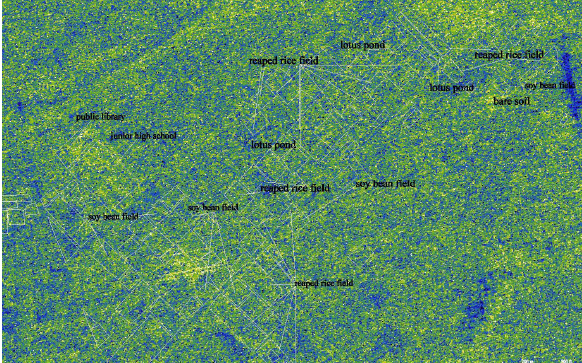
Figure 10. Zooming the RVI result of upper right part of Figure 7. image